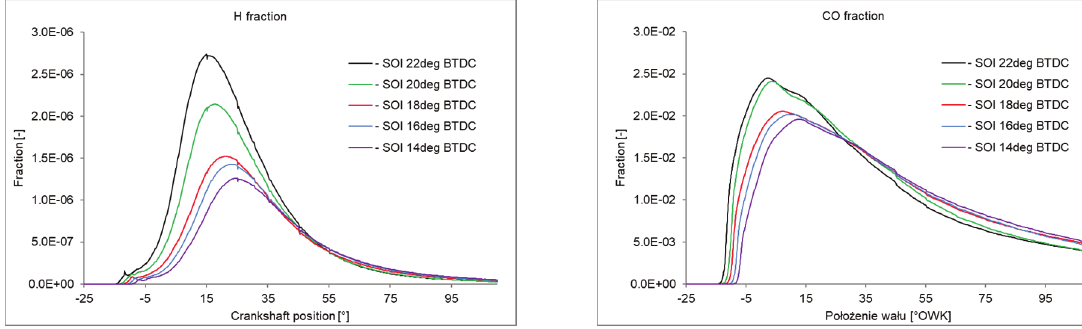
Fig. 5. Hydrogen and carbon monoxide fraction in the combustion